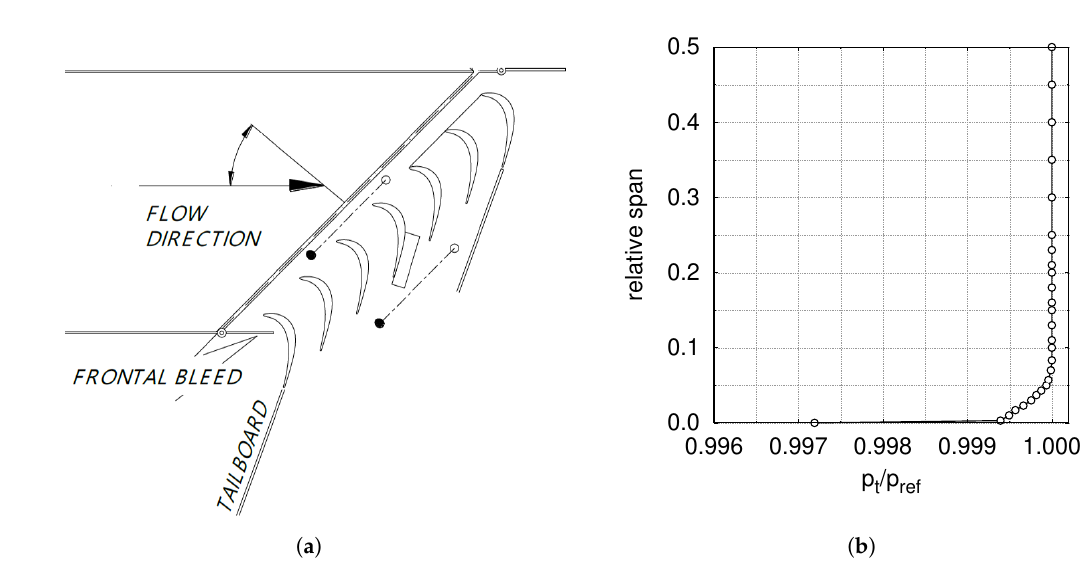
Figure 13. Wind tunnel details: ( a ) sketch of the test-rig; ( b ) reference inlet